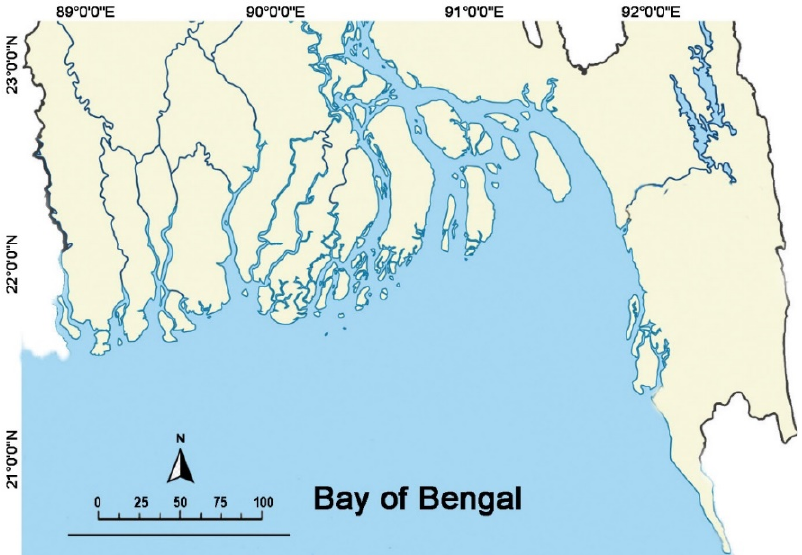
Figure 1. The map shows the study area (Bay of Bengal waters of Bangladesh).